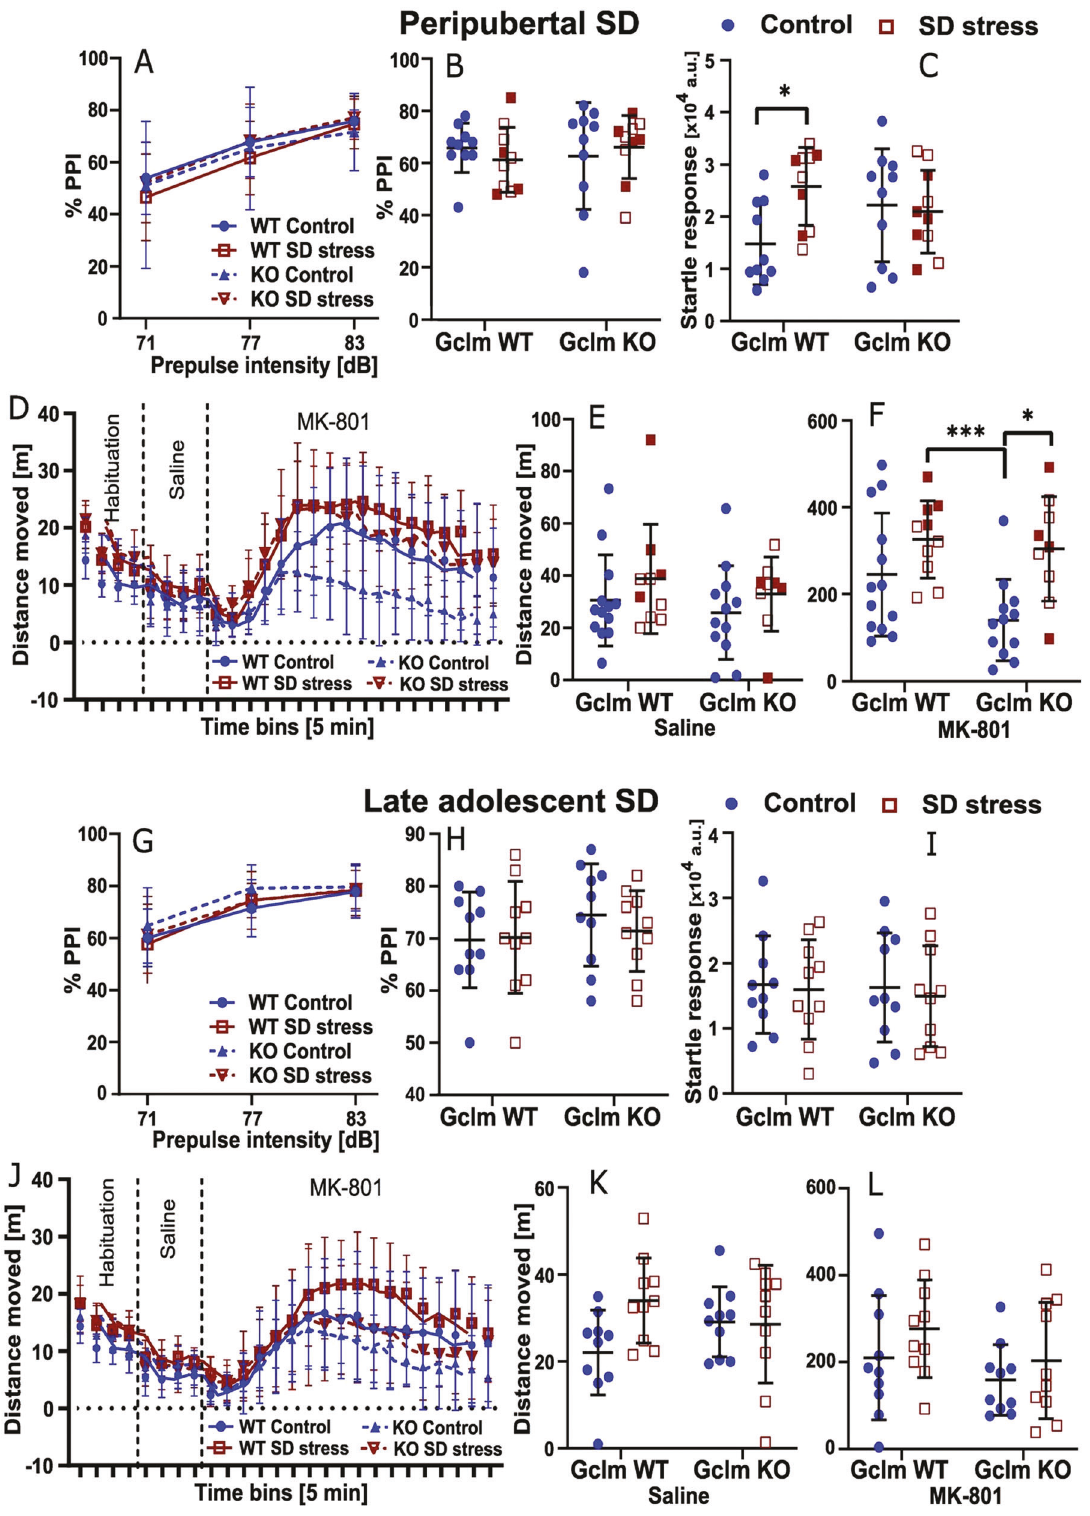
stress: F 1,40 = 13.07, = 12.2891, 1,36